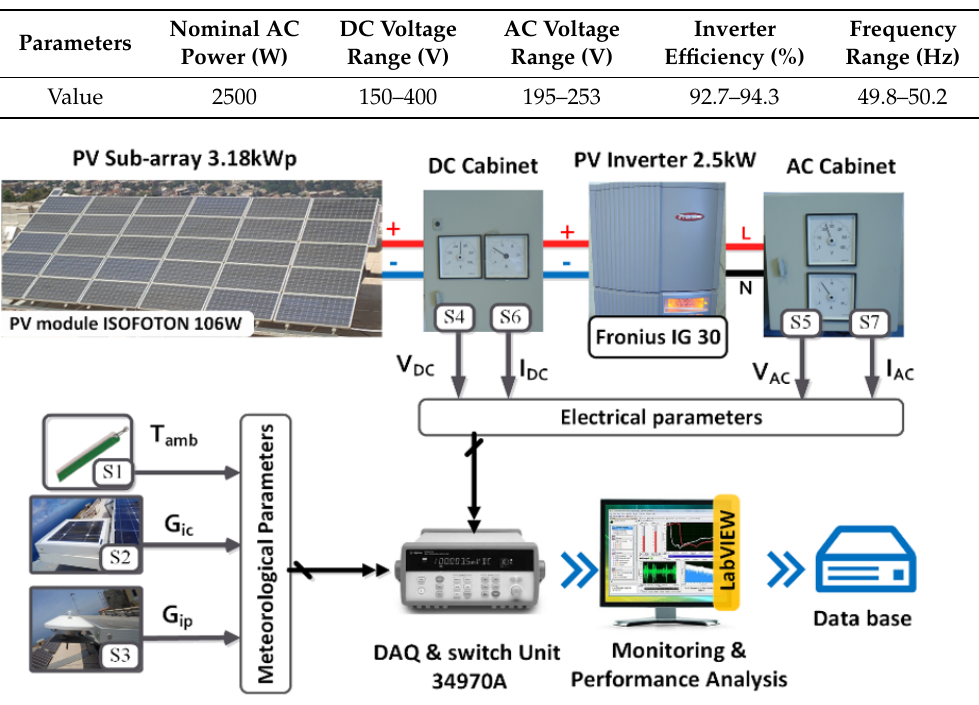
Table 2. Main specifications of the PV inverters Fronuis IG 30 under nominal operating conditions.